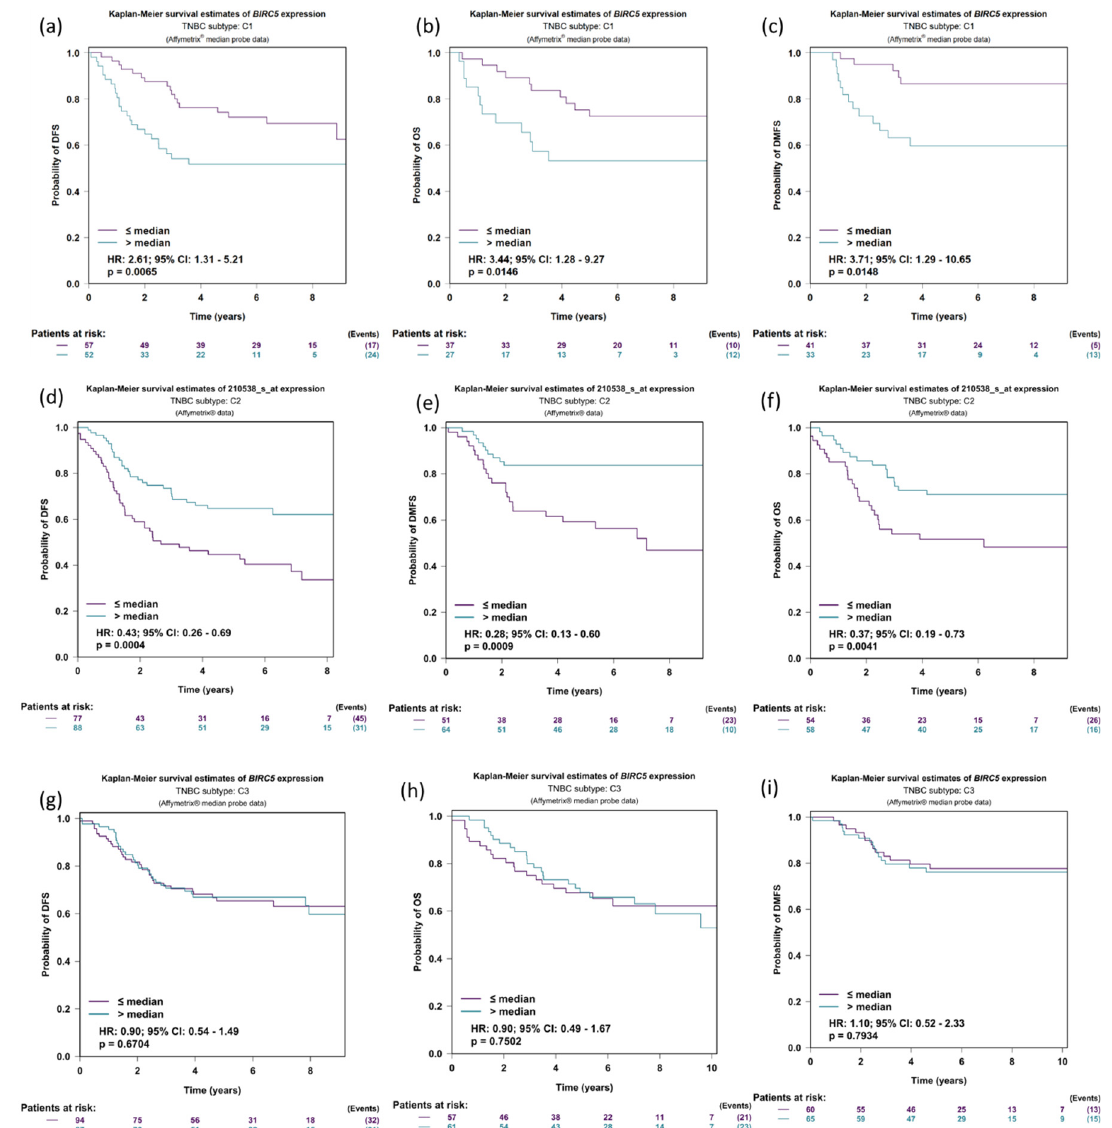
Figure 7. Expression of BIRC5 in relation to DMFS, OS, and DFS in TNBC patients. Expression of BIRC5 in population C1 ( a – c ), C2 ( d – f ), and C3 in respect to DFS (disease-free survival), OS (overall survival), and DMFS (distant metastasis-free survival) ( g – i ). For the BIRC5 gene, distributed in accordance with the splitting criterion chosen for all-event criteria (DMFS, OS and DFS), univariate Cox proportional hazards analysis and Kaplan–Meier curves are carried out (TNBC subtypes prognostic analysis module|bc-GenExMiner (unicancer.fr), accessed on 4 July 2022)).